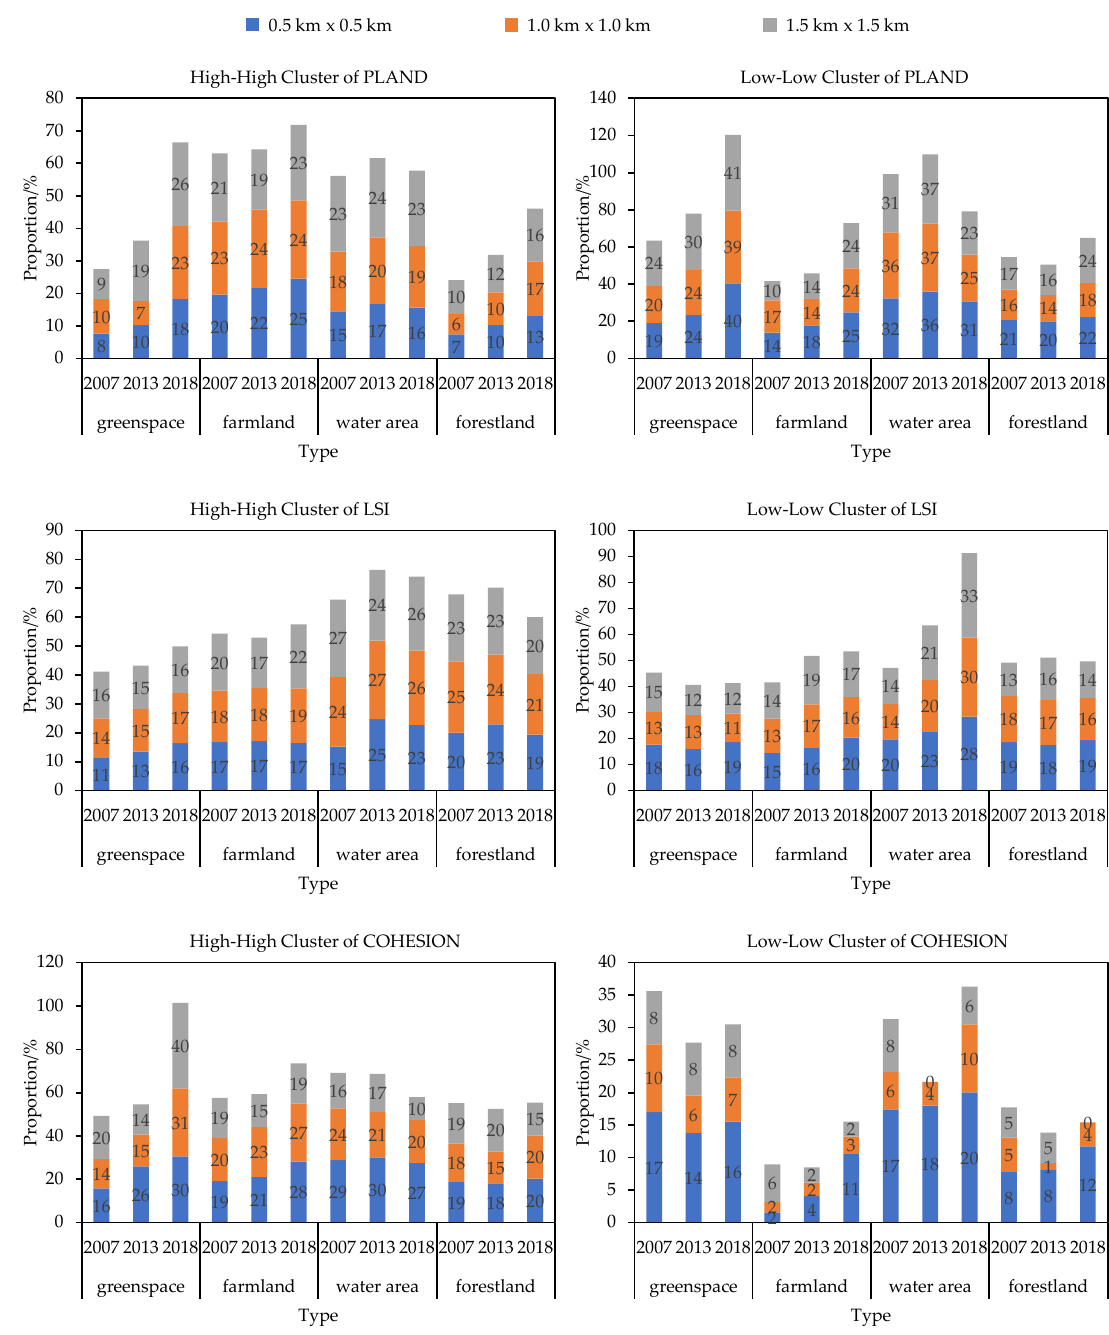
Figure 8. The proportions of high-high and low-low clusters